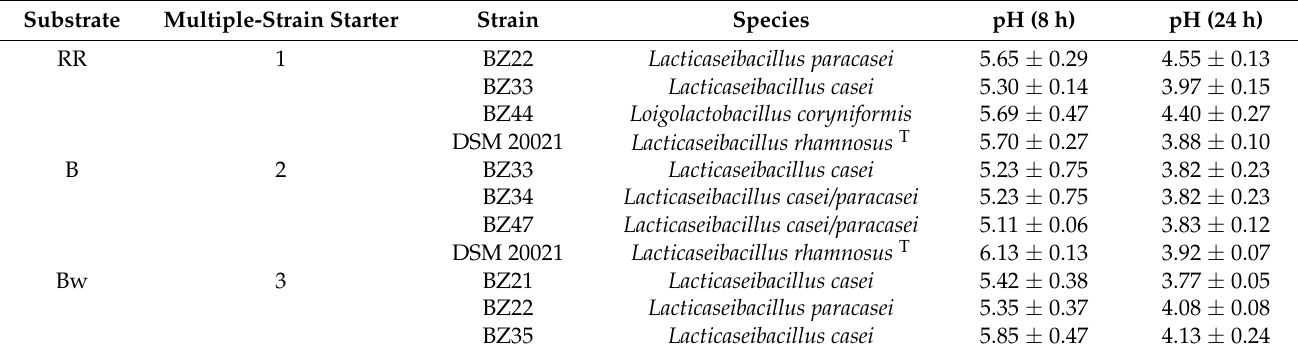
Table 3. Multiple-strain starters specifically formulated for the manufacture of laboratory-scale prototypes of the three fermented beverages with red rice (RR), barley (B) and buckwheat (Bw). Substrate Multiple-Strain Starter